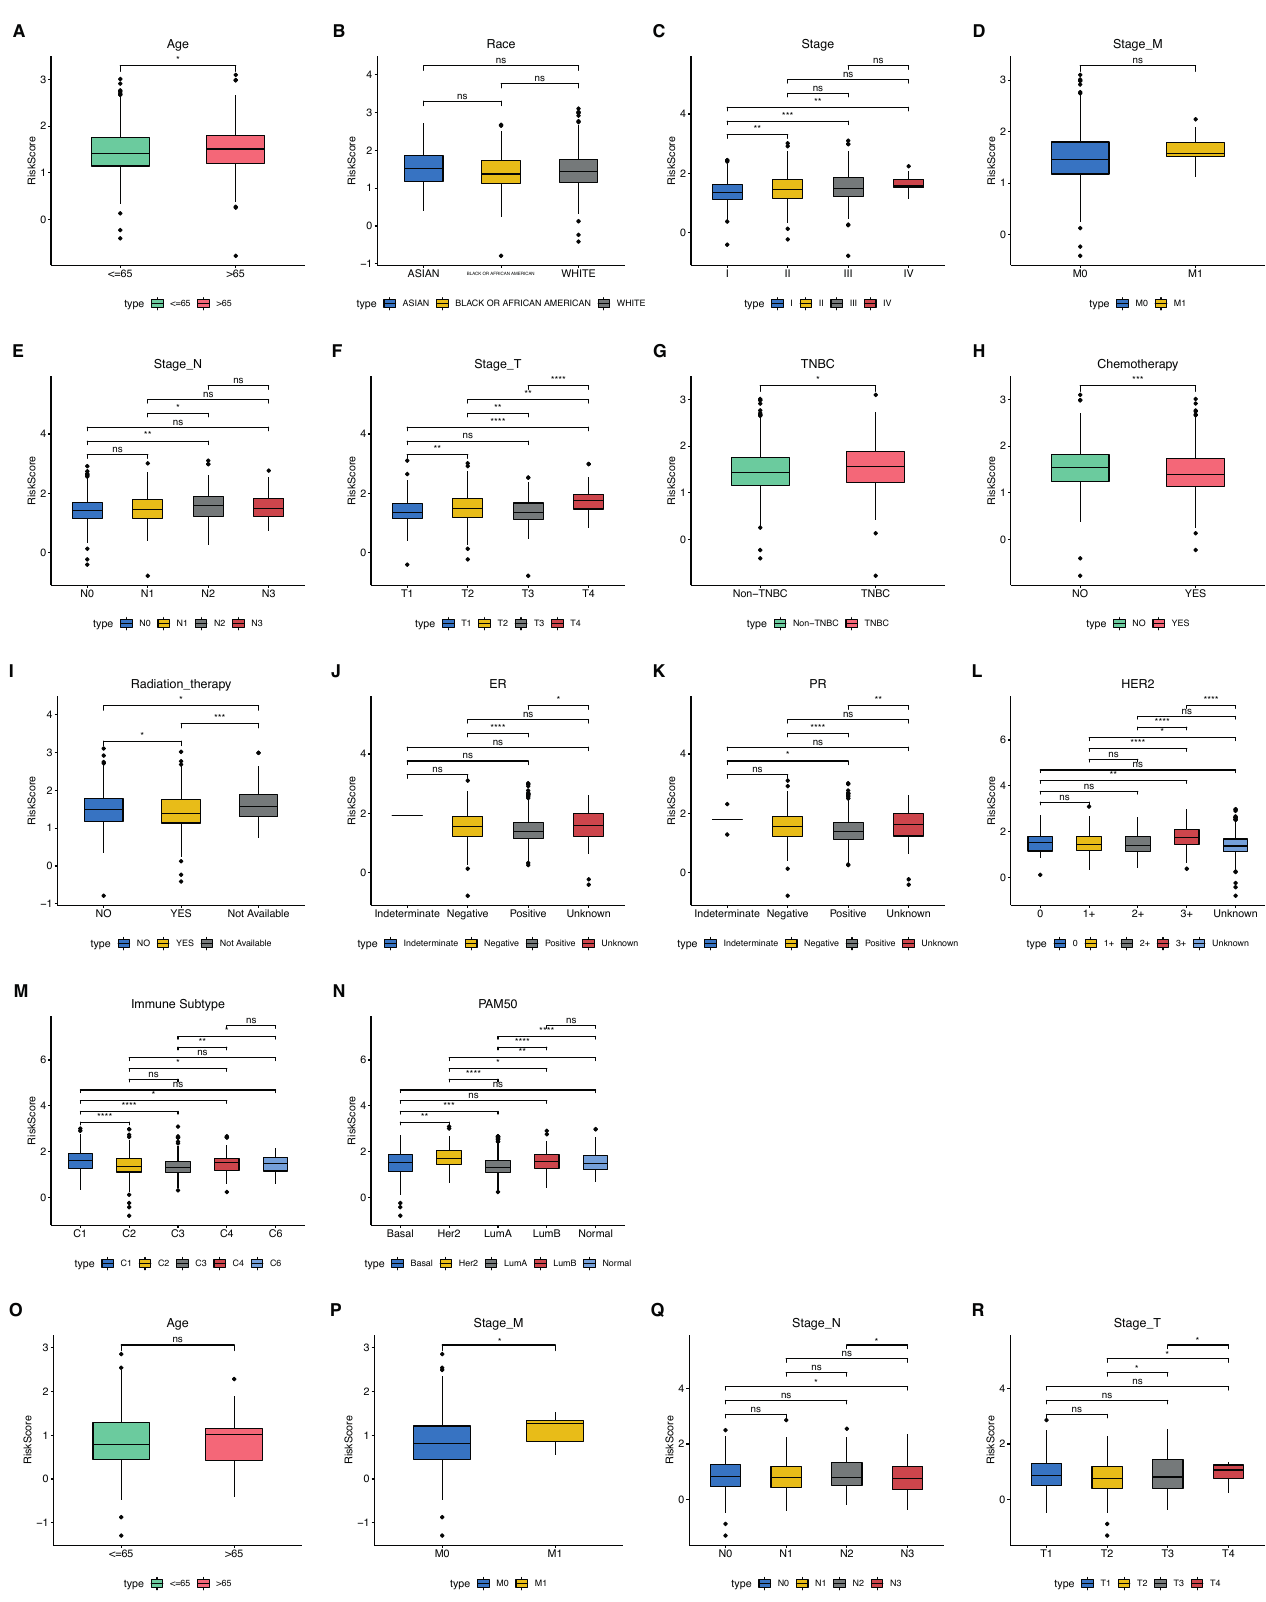
Figure 10. Clinical feature signature differences: ( A – N ) TCGA dataset; ( O – R ), G SE20685 dataset. (* p < 0.05, ** p < 0.01, *** p < 0.001, **** p < 0.0001, and ns p value >